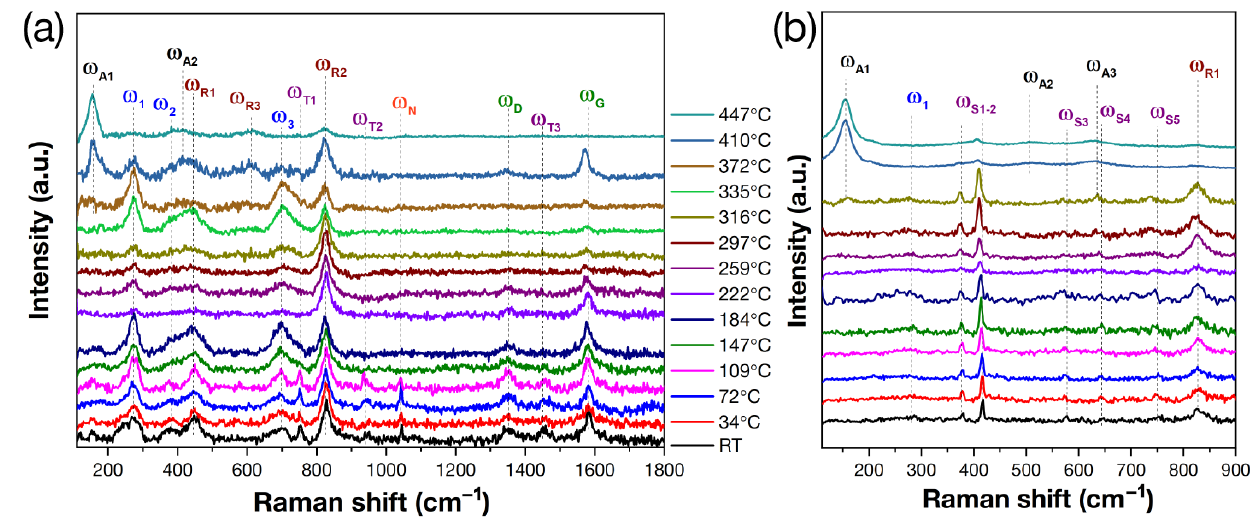
Figure 3. In situ Raman spectra at different temperatures (20 – 447 °C) of the thin film at different substrate areas: on Pt ( a ) and Al 2 O 3 ( b ).